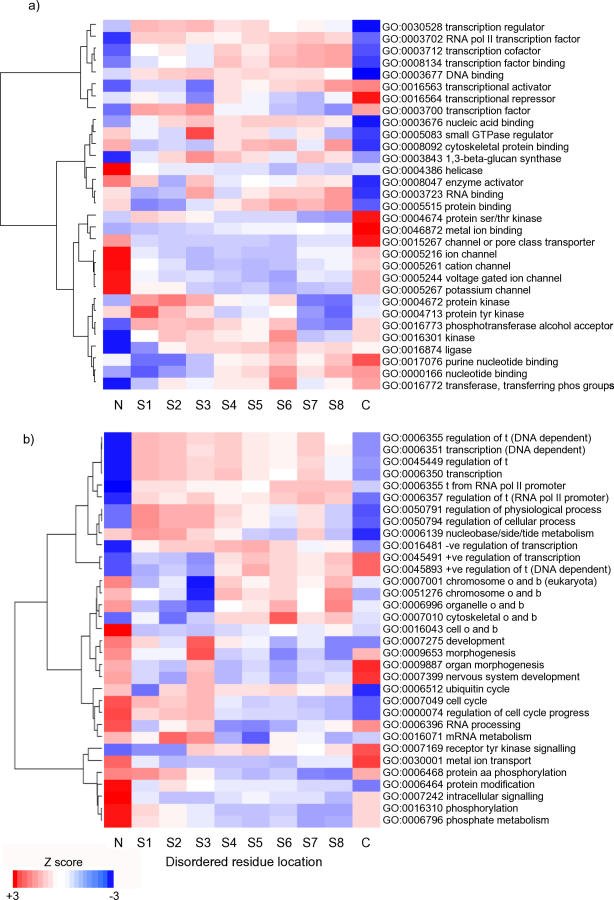
Location Features Encoding Protein Disorder for Molecular Function (A) Categories and Biological Process (B) Categories That Are Enriched in Disordered ProteinsThe locations are represented on the x-axis from N terminus through equally proportioned mid segments S1–S8 to C terminus. The clustering of GO categories was performed using Ward's hierarchical clustering method [30]. The heatmap colours reflect the significance of the association between the frequency of disordered residues within the location region and the GO category. Red blocks indicate that a high average frequency of disordered residues is associated with the GO category and the location region. Blue blocks indicate an association between low average frequency of disordered residues in the location and GO category.